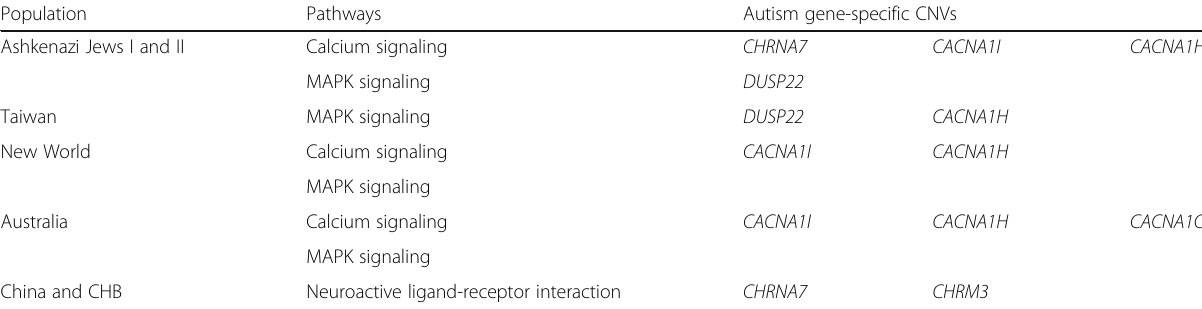
Table 3 Pathway enrichment analysis of autism gene CNVs across 12